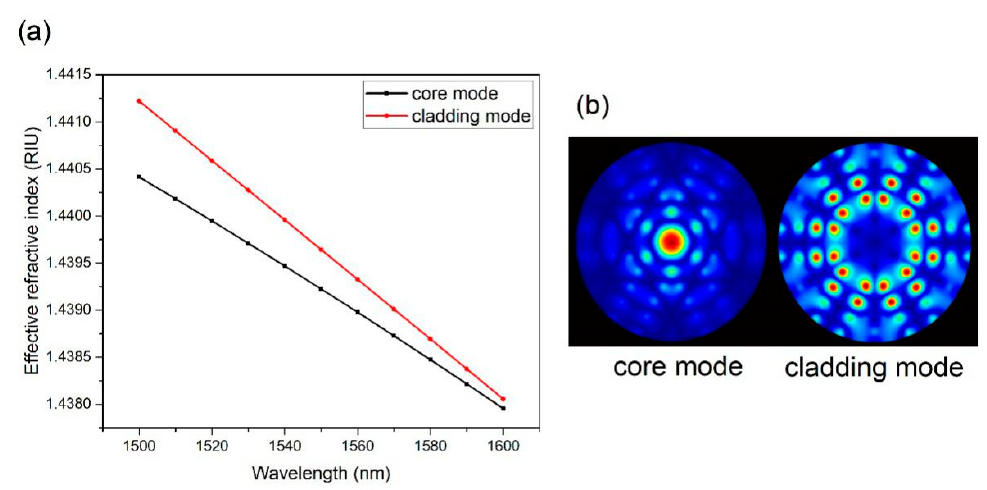
Figure 4. ( a ) The effective refractive indexes of the core and cladding modes; ( b ) The electric distributions of the core and the cladding modes in an MOF at 1550 nm.